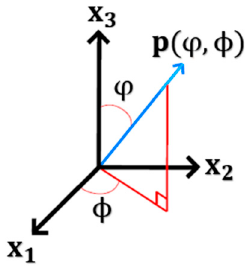
Figure 6. Coordinates of the vector p ( ϕ , φ ) defining by the angles ϕ and φ